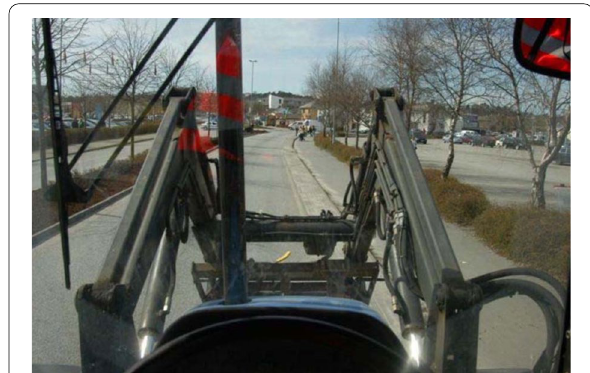
Fig. 7 The front end loader on tractors or similar vehicles also creates forward-looking blind spots, which have similar basic properties as those created by A-pillars. From Ringen and Moss-Iversen (2017), reprinted with permission